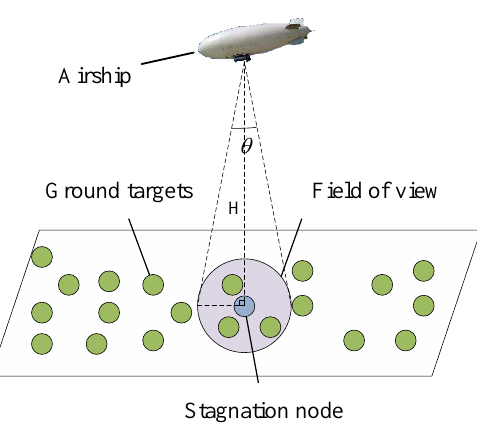
Figure 1. An example of the HAA observation